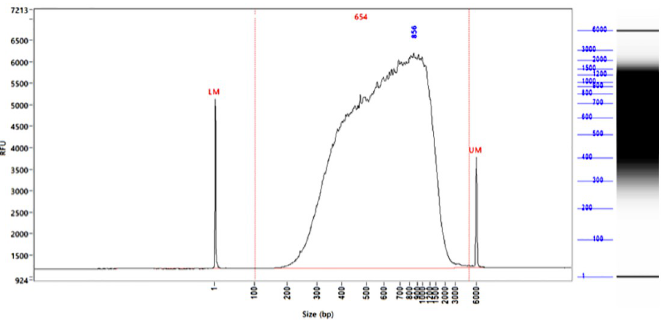
Fig 1. Generated libraries have the size of the average circRNA length. Shown is the library created from RNA of the anaplastic large-cell lymphoma cell line SU-DHL-1. The library size was analyzed by Fragment Analyzer with the kit hs NGS. The average library size was 654 nt. RFU, relative fluorescence units.